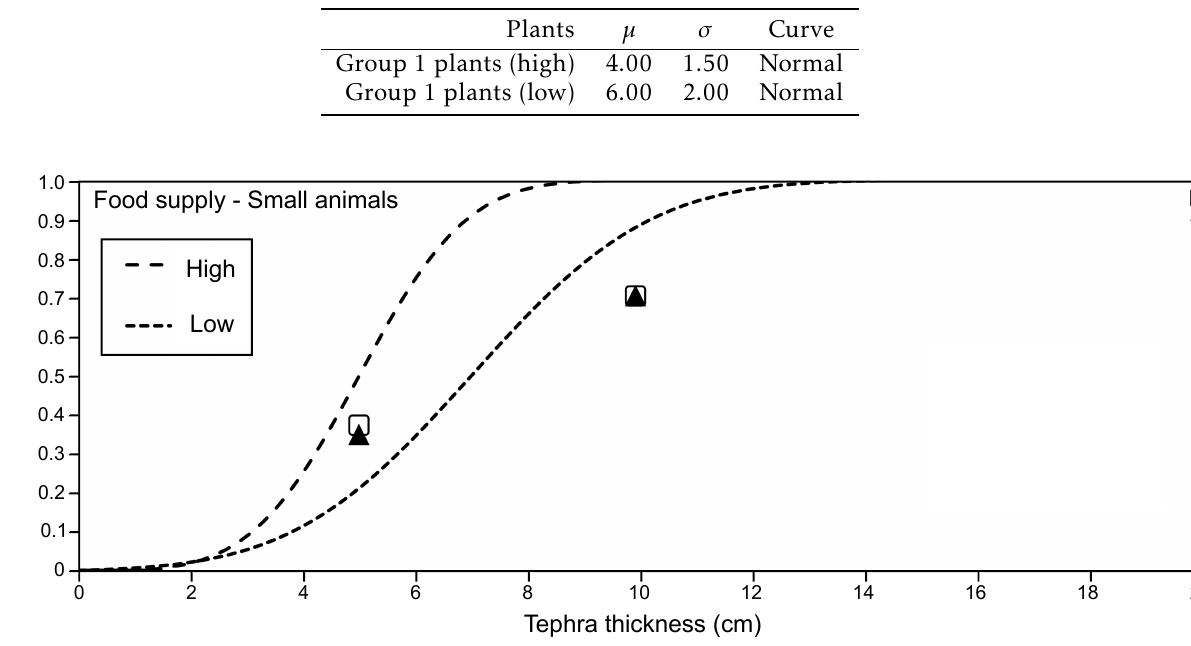
Figure A4: Estimated high and low vulnerability indices for small animals exposed to 0–20 cm of tephra fall from the Laacher See eruption. Boxes = Participant A, Triangles = Participant B estimates of vulnerability for 5, 10, and 18–20 cm of compacted tephra. Table A4 – Fitting parameters for vulnerability curves based on food supply (small animals) in Figure